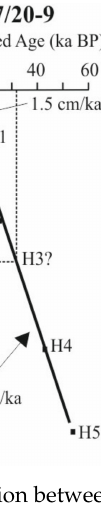
Figure 7. Correlation plot of the six gravity cores studied from the Hatton Bank–Rockall Plateau where the ash layer and Heinrich Events (HE) identified in this study are shown. Two columns are plotted for each gravity core: picture on the left side and an interpretation sketch on the right side.